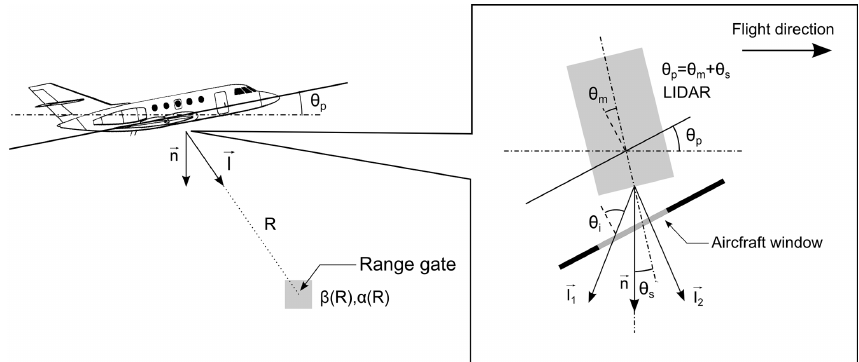
Figure 1. Variables used to calculate the backscattered power from a given range gate, where R is the distance between the range gate and the lidar, I is a unit vector that represents the line of sight (LOS) of the lidar, n is the unit nadir pointing vector, β (R) is the backscatter coefficient and α(R) is the extinction coefficient of the sampled atmospheric volume. The zoomed area shows a mounting scheme of the lidar transceiver head. I 1 and I 2 are examples of the LOS vector when the instrument operates in scanning mode, θ p is the aircraft pitch angle, θ m is the lidar mounting angle about the transverse aircraft axis, θ s is the angle between the transceiver head geometric axis and n , and θ i is the angle of incidence of the transmitted laser beam on the aircraft